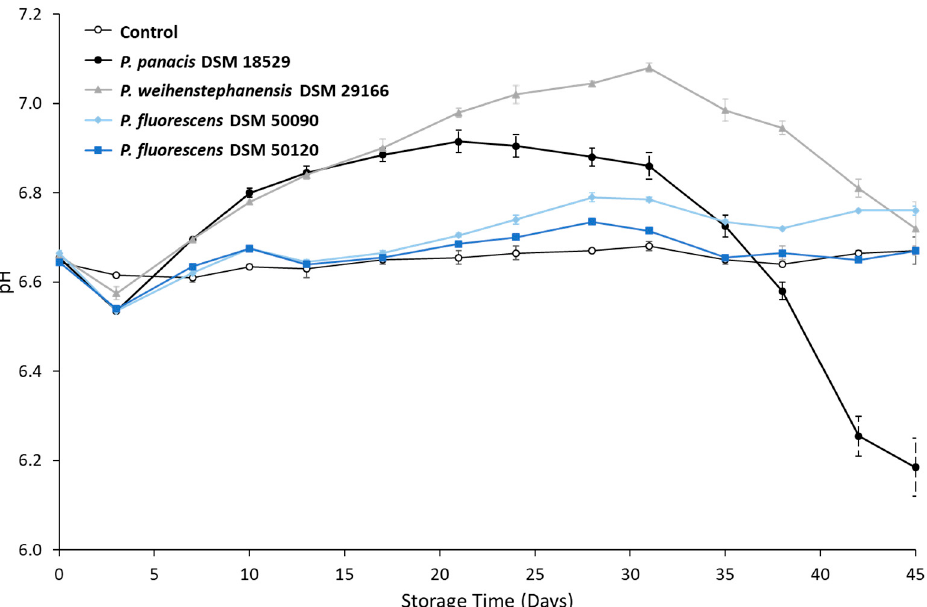
Figure 2. Development in pH of skimmed UHT milk inoculated with the four studied bacterial extracellular extracts and the control during storage for 45 days at 20 °C. The measurements were carried out in biological replicates (n = 2).